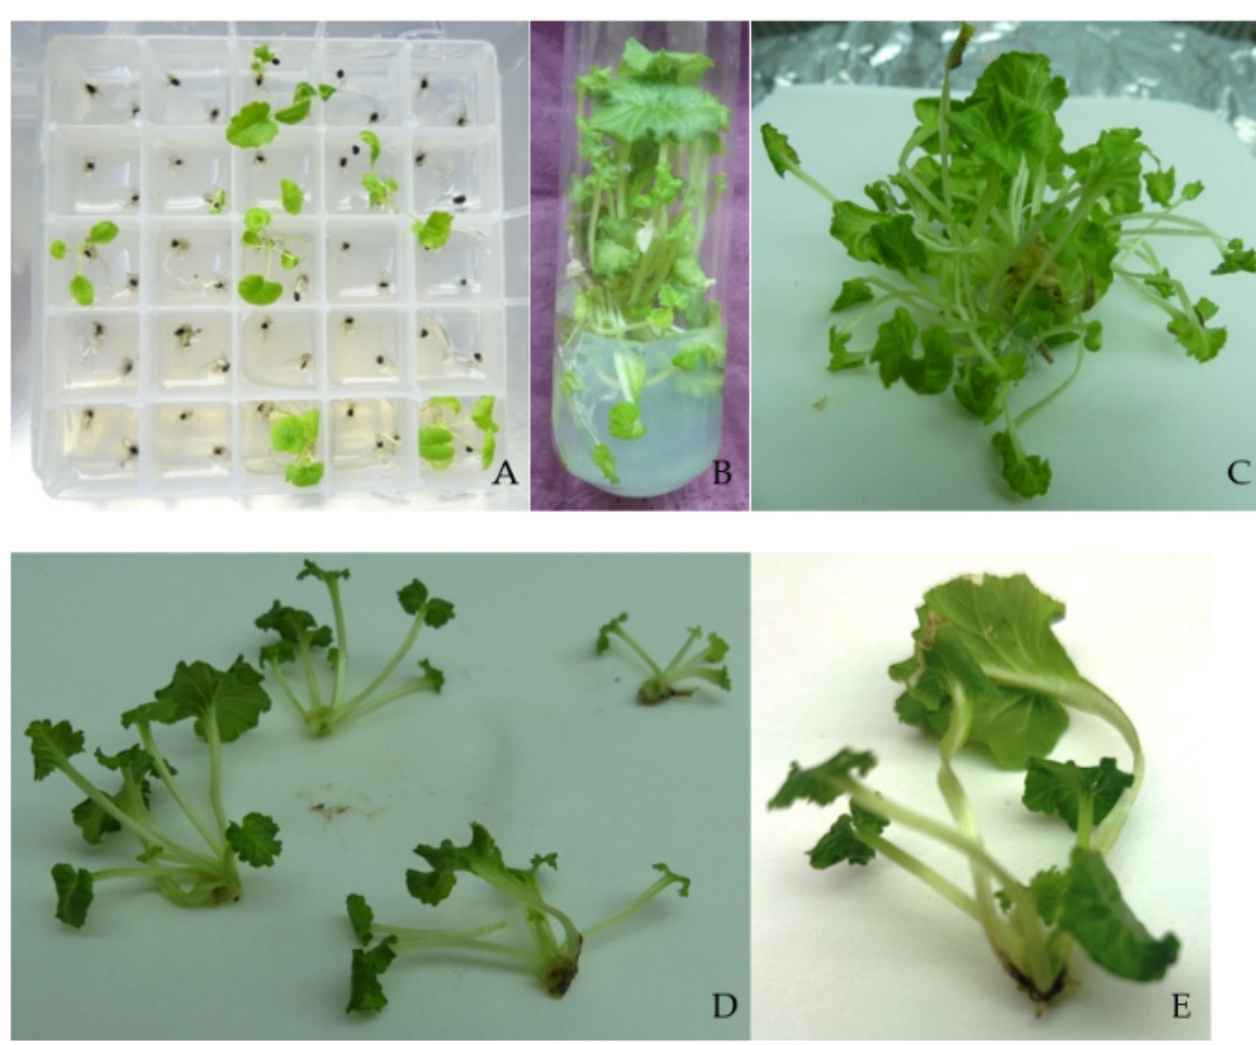
Figure 1. In vitro cultivation of P. veris : ( A ) Seed germination on medium G1K 5 ; ( B , C ) Shoot-clump after sub-cultivation on medium B1D 2 .; ( D ) Separated shoots from the shoot-clump; ( E ) Shoot with rudiments of